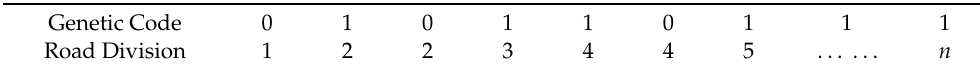
Table 5. Genetic code illustration using